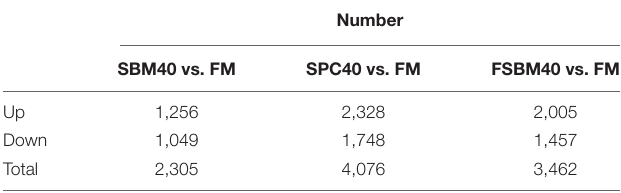
Frontiers in Marine Science |